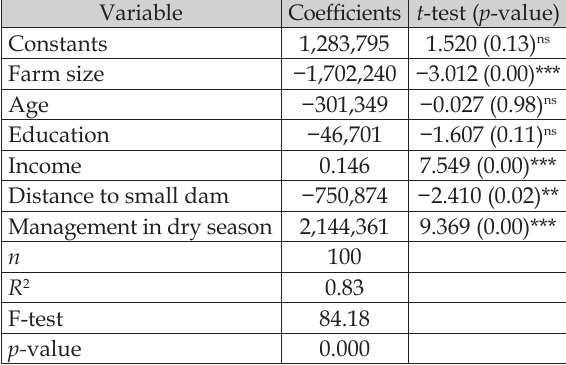
Table 5. Estimation results of the